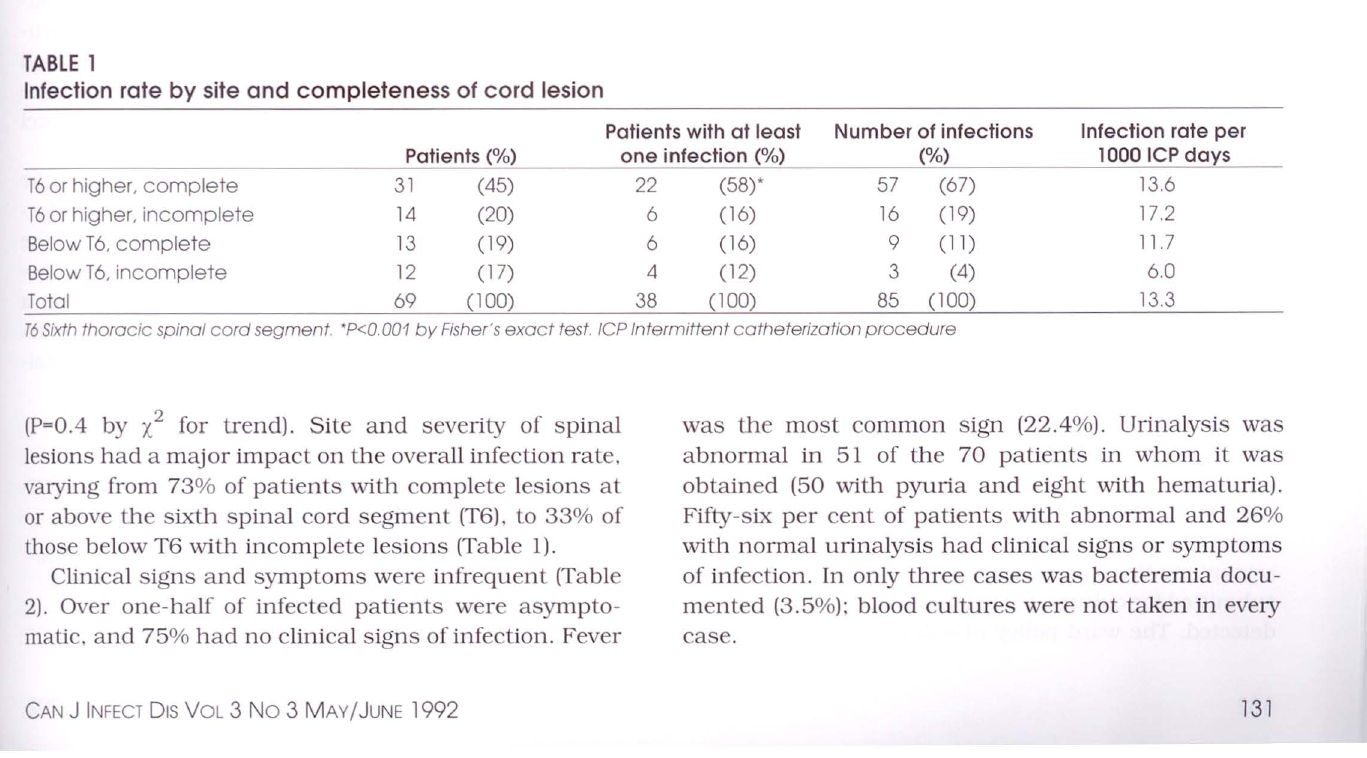
Patients with at least Number of